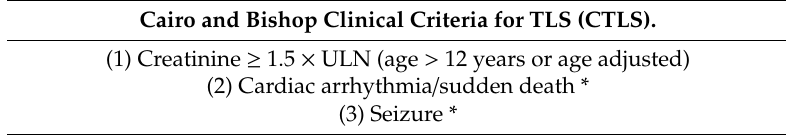
Table 3. Cairo and Bishop clinical criteria for TLS (clinical tumor lysis syndrome, CTLS). Cairo and Bishop Clinical Criteria for TLS